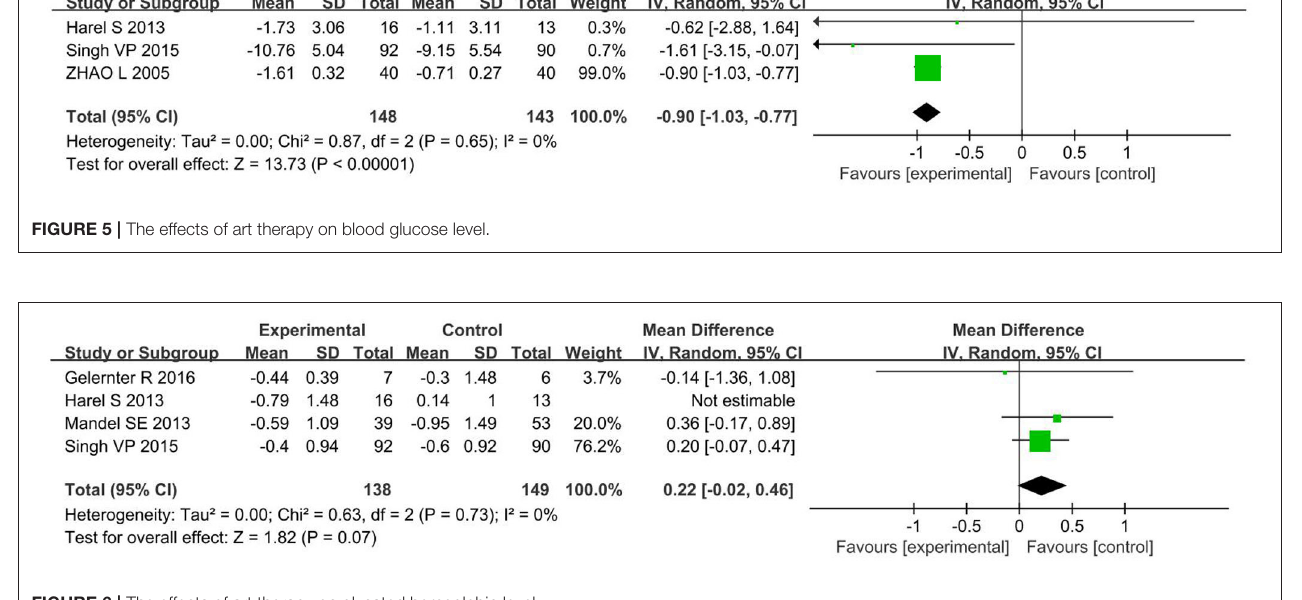
FIGURE 6 | The effects of art therapy on glycated hemoglobin